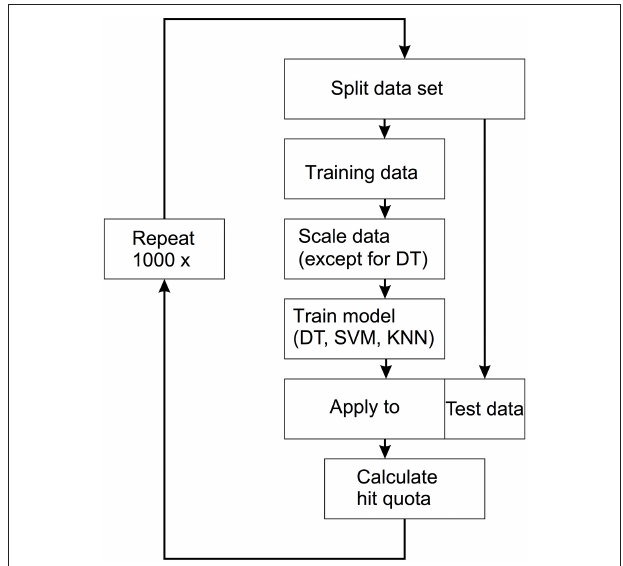
FIGURE 2 | Workflow for the applied supervised machine learning technique. The data set is split into a training set (66% of the data) and a test set (33% of the data). The three models [decision trees (DT), support vector machine (SVM), k-nearest neighbors (KNN)] were then fitted to the training data. The models are then applied to the test data and the hit quota is calculated. This process is repeated 1,000 times.